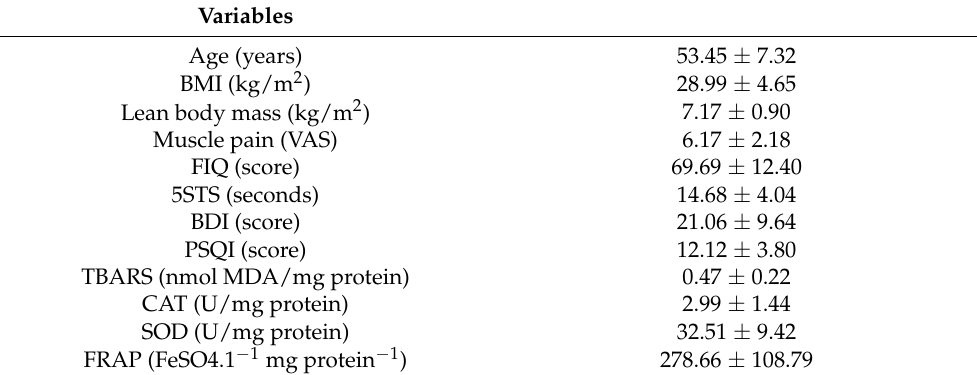
Table 1. Characteristics of fibromyalgia patients ( n =